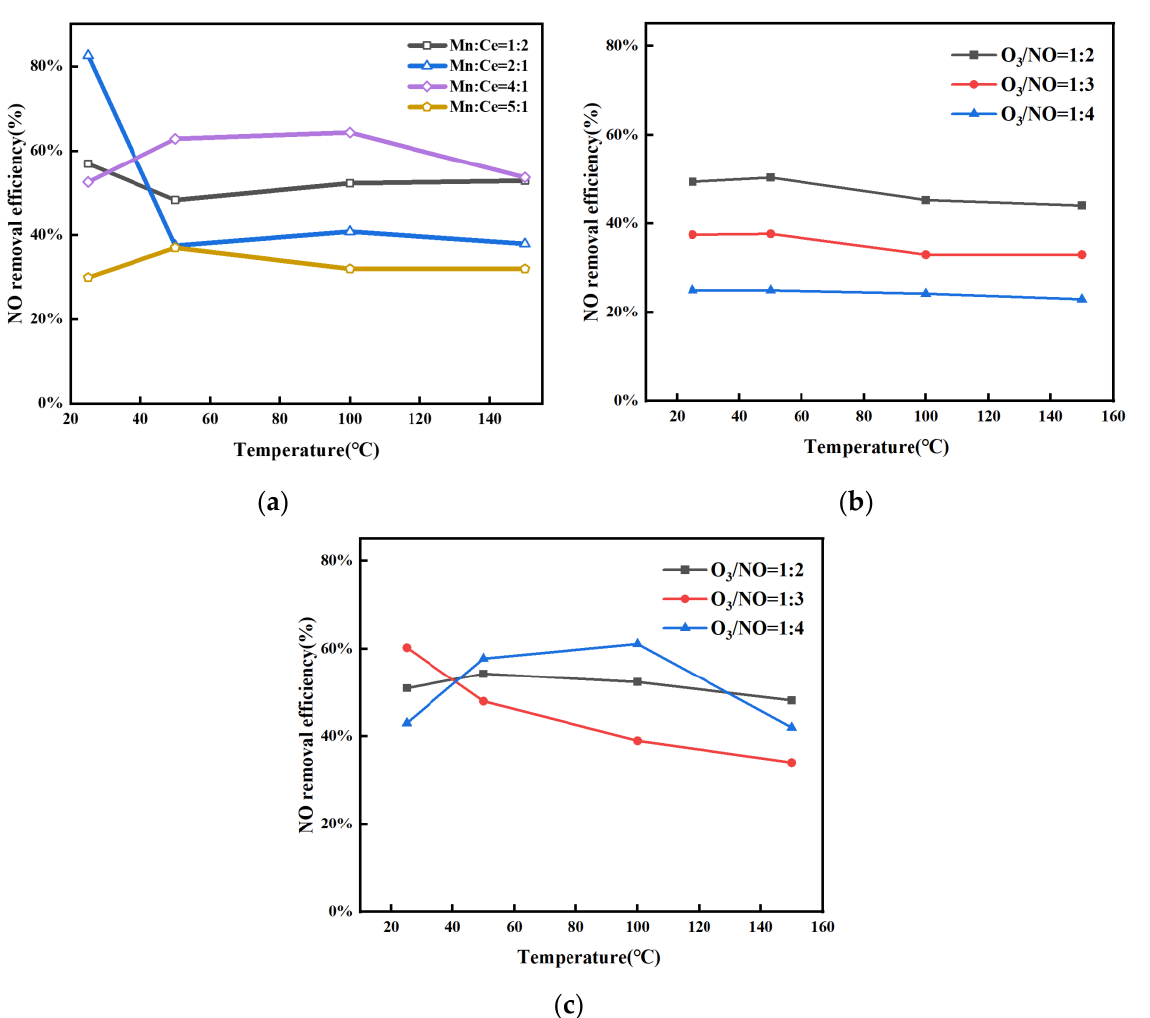
Figure 4. ( a ) The efficiency of catalysts with different Mn:Ce molar ratios for the catalytic ozonation of NO when the volume of O 3 :NO = 1:4; ( b ) The effect of increasing the ratio of O 3 on NO removal without catalyst; ( c ) Under the synergistic catalysis of Mn-Ce (4:1)/Al 2 O 3 /TiO 2 catalyst, increasing the ratio of O 3 on NO removal Impact.